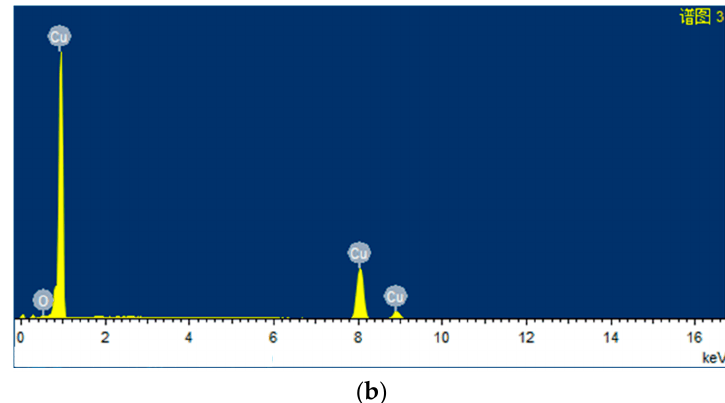
Figure 2. ( a ) Scanning electron microscope (SEM) image and ( b ) Energy dispersive spectrometer (EDS) results of copper particles.